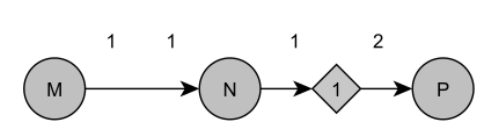
Figure 2. Example of a Synchronous Dataflow (SDF) with one initial delay among actors N and P (adapted from